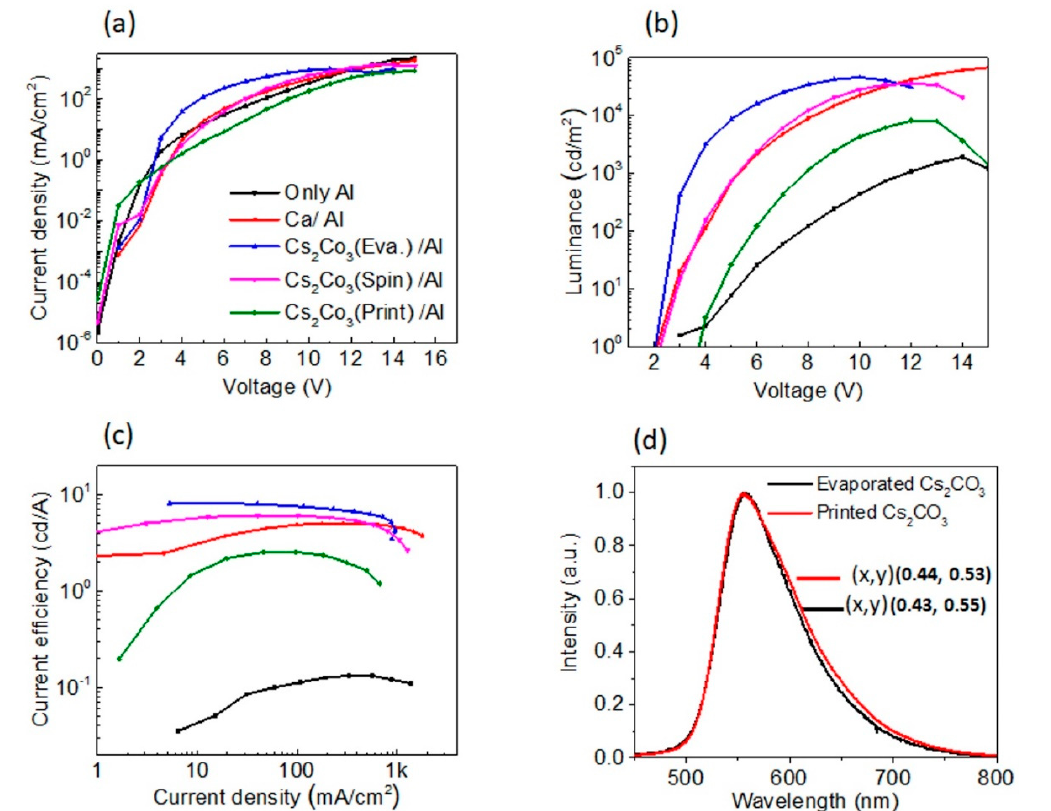
Figure 8. Characteristics of PLEDs with different cathode systems: ( a ) current density vs. voltage; ( b ) luminance vs. voltage; ( c ) current efficiency vs. current density; and ( d ) electroluminescence spectra. Table 3. Turn-on voltage, maximum luminance and maximum current efficiency of PLEDs based on SY with different cathode systems.